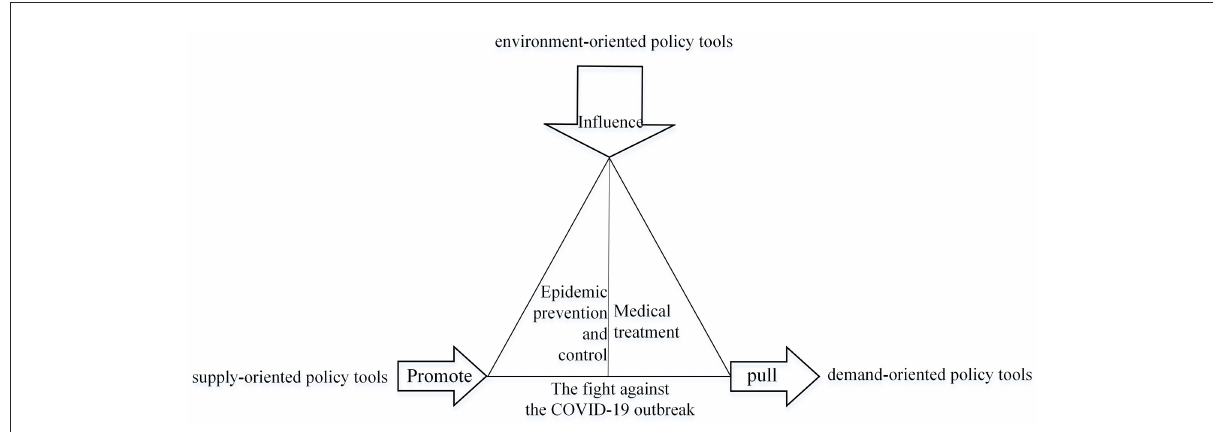
FIGURE1 The role of different types of policy tools in the fight against the COVID-19 outbreak in China.